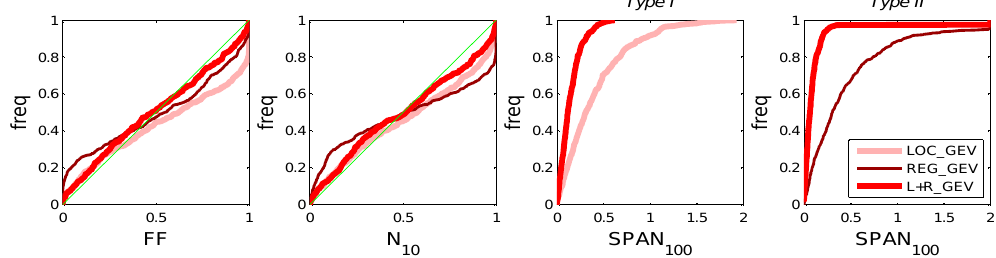
Fig. 6. Reliability ( FF , N 10 ) and stability (SPAN 100 – type I, SPAN 100 – type II) indices for local, regional and local-regional estimation of a GEV